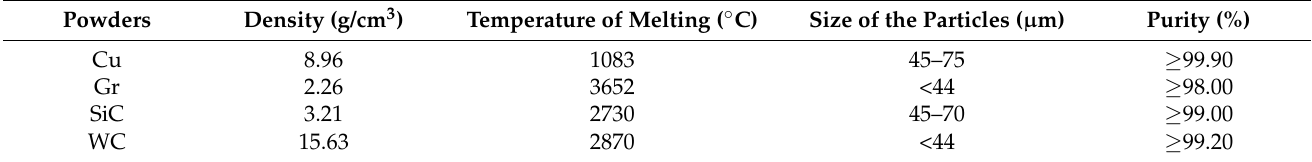
Figure 1. Micrographs of the powders used in the tests taken using a SEM. Table 1. Some powder particle characteristics.